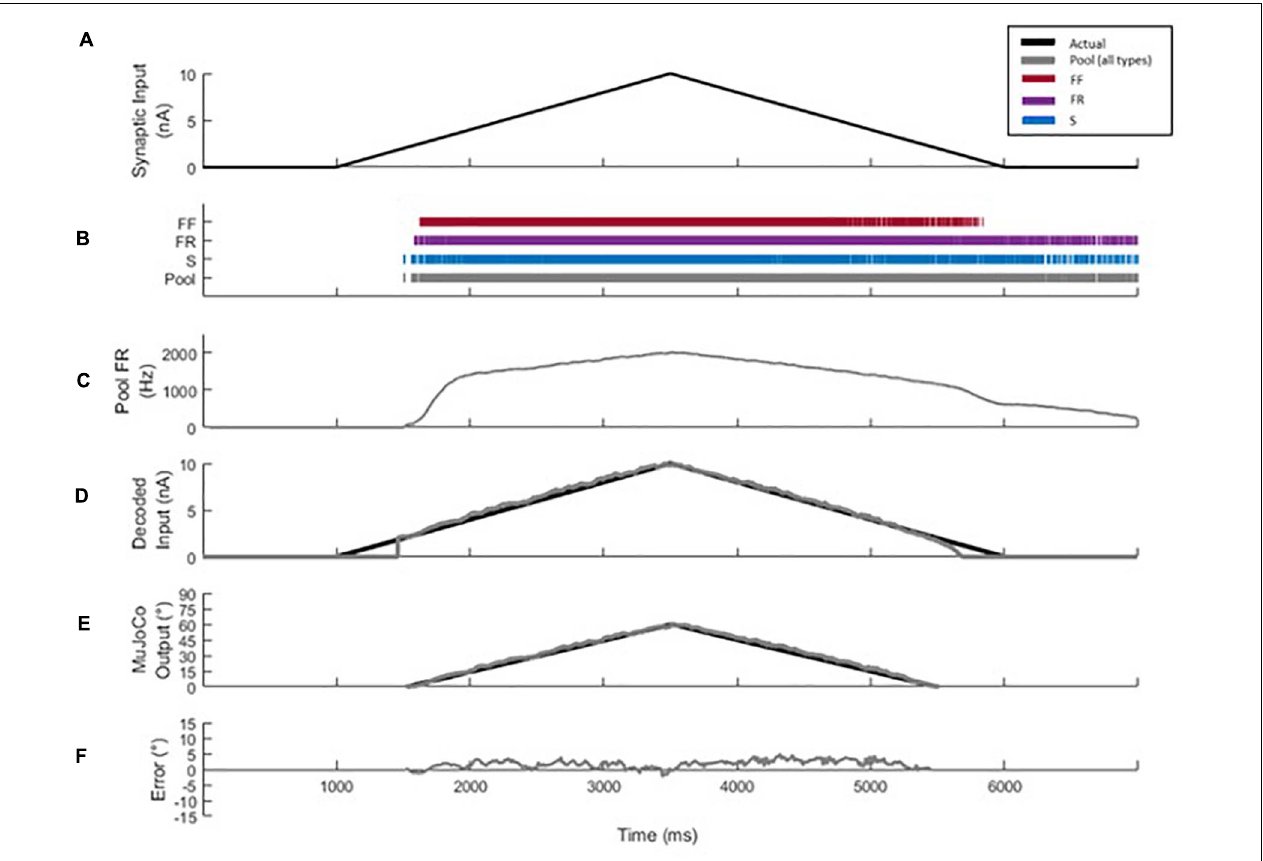
FIGURE 2 | Decoder development and performance. (A) Profile of the excitatory synaptic input command to the pool model to activate the motor pool. The input increases and decreases at 4 nA/s to a peak level of 10 nA. (B) Spikes of type S (blue), FR (purple), and FF (red) MNs are combined to form the aggregate motor pool spikes (gray). The spikes highlight the recruitment order and self-sustained firing characteristics of S and FR cell types, relative to the FF type. (C) Smoothed aggregate firing rate of the motor pool. (D) Comparison of decoded vs. actual synaptic inputs. (E) Profiles of MuJoCo’s hand position when driven by the actual synaptic input (black) vs. the decoded input (gray). (F) The instantaneous error in MuJoCo’s hand position, calculated as the difference between MuJoCo’s hand position angles when driven by the actual vs. the decoded inputs (same color code as in